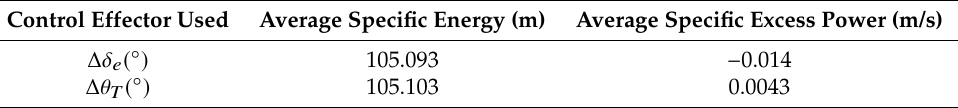
Table 11. Aircraft Model 2 pull up maneuver control effector comparison using ∆ δ e or ∆ θ T